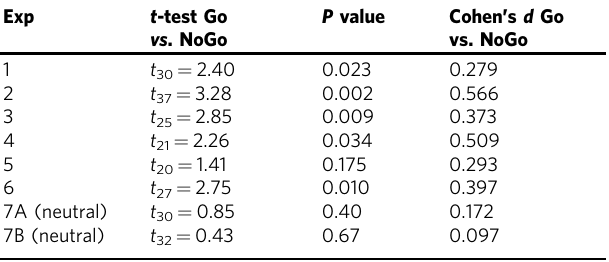
Table 2 Accuracy comparison between Go and Ngo